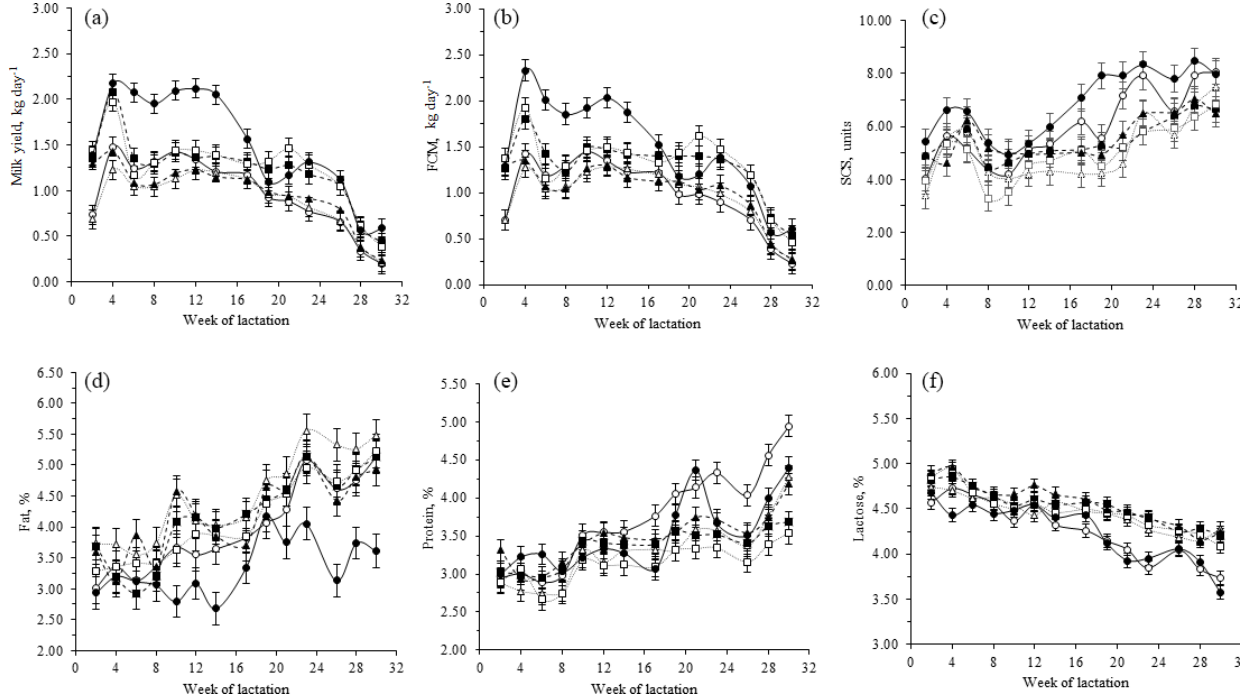
Figure 2. Least squares means (with SE) for (a) milk yield, (b) fat-corrected milk at 3.5% (FCM), (c) somatic cell score (SCS), (d) fat percentage, (e) protein percentage, and (f) lactose percentage for Garganica, Girgentana, Maltese, Saanen, Mediterranean Red and Jonica goat breeds across lactation. Garganica ( (cid:13) ), Girgentana ( (cid:52) ), Maltese ( (cid:3) ), Saanen ( • ), Mediterranean Red ( (cid:78) ), and Jonica ( (cid:4) ) goat breeds across